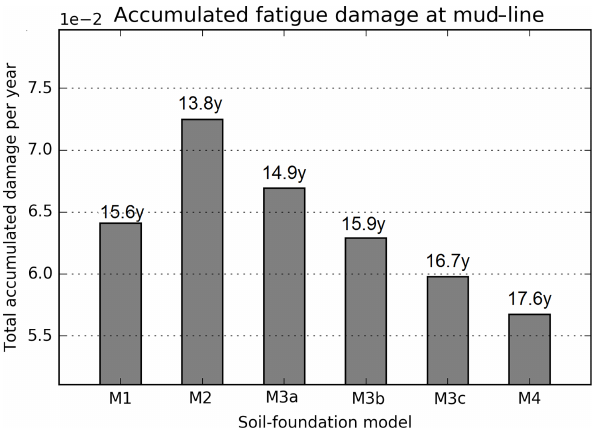
Figure 19. Accumulated fatigue damage at mud-line.